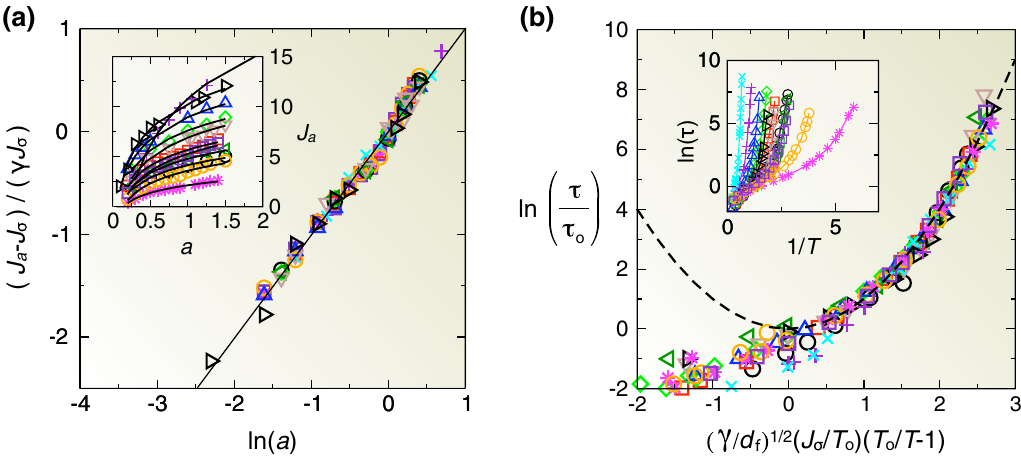
FIG. 4. Hierarchical excitation-energy scales predict observed structural-relaxation times. (a) Demonstration of logarithmic growth of J a with respect to a [Eq. (2)]. Fit parameters are given in Table II. The inset shows the uncollapsed data. The data set 2D- 68:32 , (cid:8) ¼ 0 : 75 is omitted for clarity in the inset, as its scale obscures the other data sets. (b) Structural-relaxation times predicted from results shown in Figs. 3(d) and 4(a), which are compared to measured relaxation times. Parameters from statistics are listed in Table II. Data symbols are the same as those in Fig. 3(d).